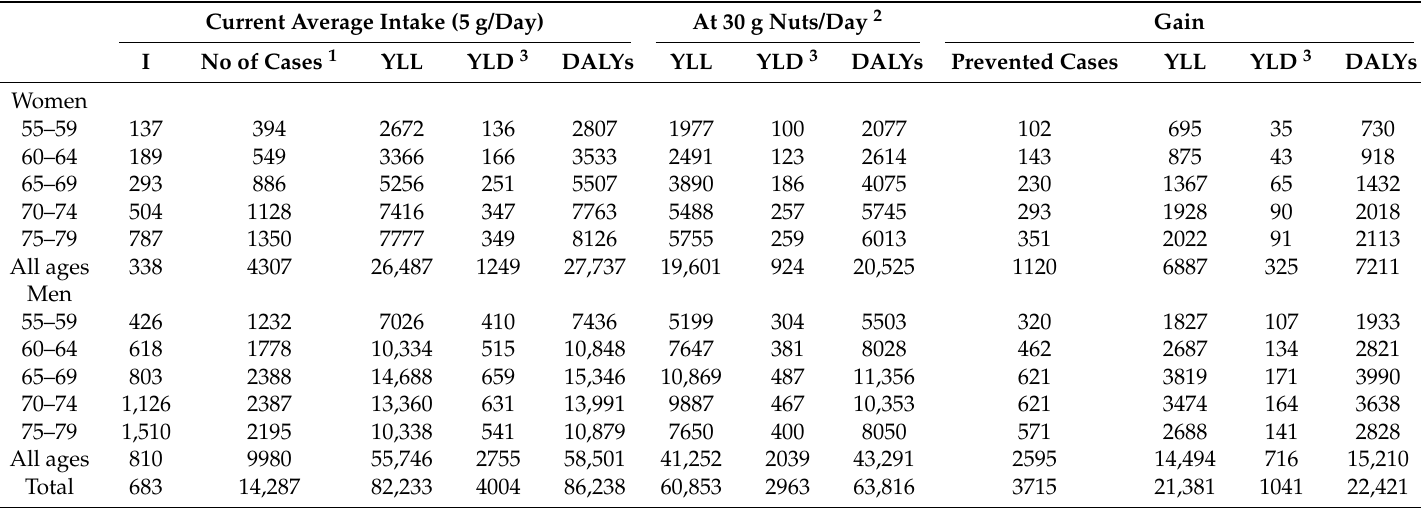
Table 1. Estimated absolute gain in health impact attributable to first incident MI in the Swedish population aged 55–79 years in 2013, by increasing the nut consumption from current average of 5 g/day to a scenario where everyone consumes 30